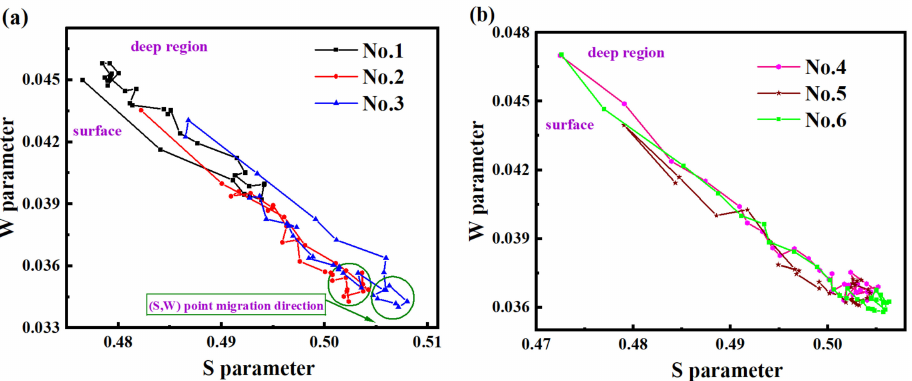
Figure 4. S - W curves of pure titanium samples before and after electrochemical hydrogenation: ( a ) S - W curves of well-annealed samples after electrochemical hydrogenation; ( b ) S - W curves of cold-deformed samples after electrochemical hydrogenation (where “surface” represents the position of the surface area and “deep region” represents the interior of the